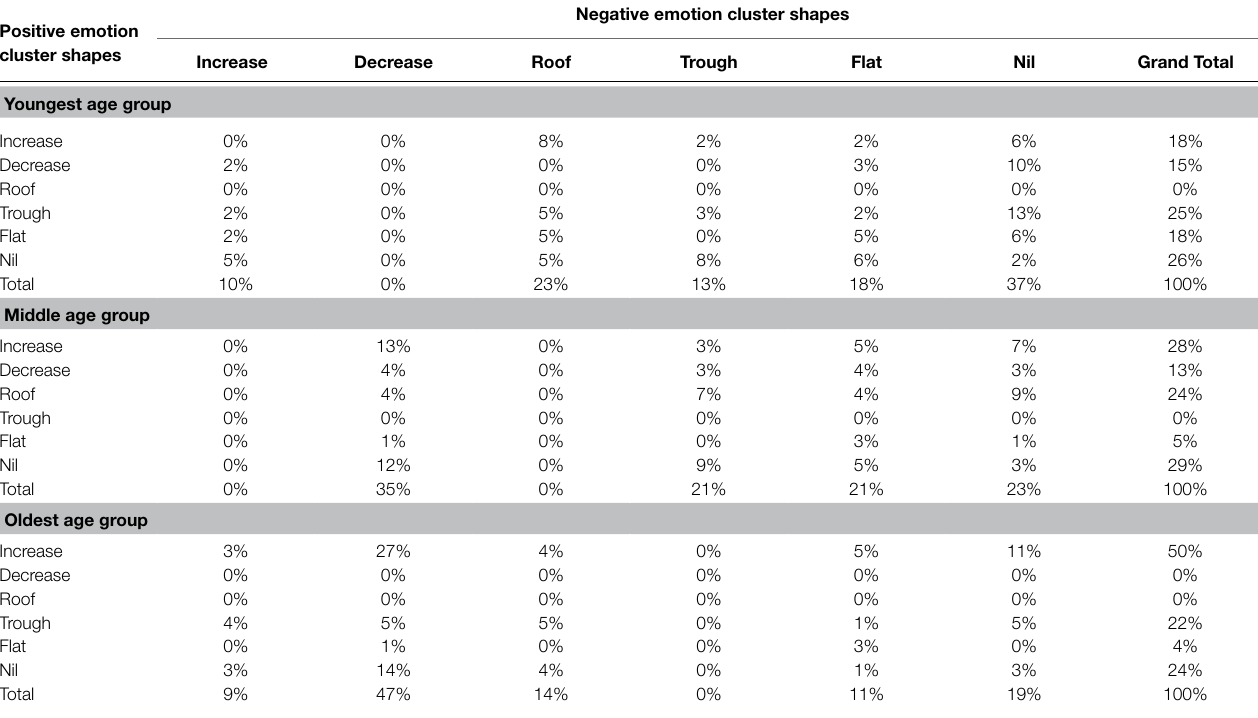
TABLE 2 | The proportion of cluster type reported in the negative emotions for each cluster type reported in the positive emotions. Negative emotion cluster shapes Positive emotion cluster shapes Increase Decrease Roof Trough Flat Nil Grand